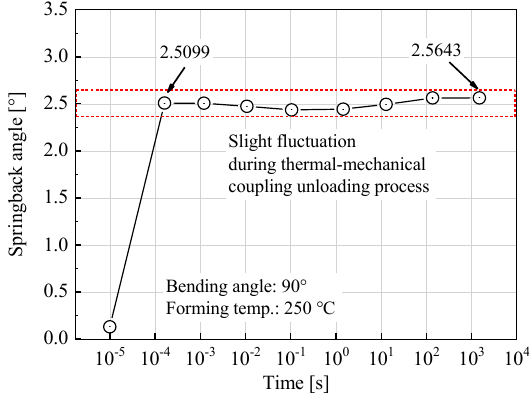
Figure 7. Springback vs. unloading time under 90° bending angle at 250 °C.